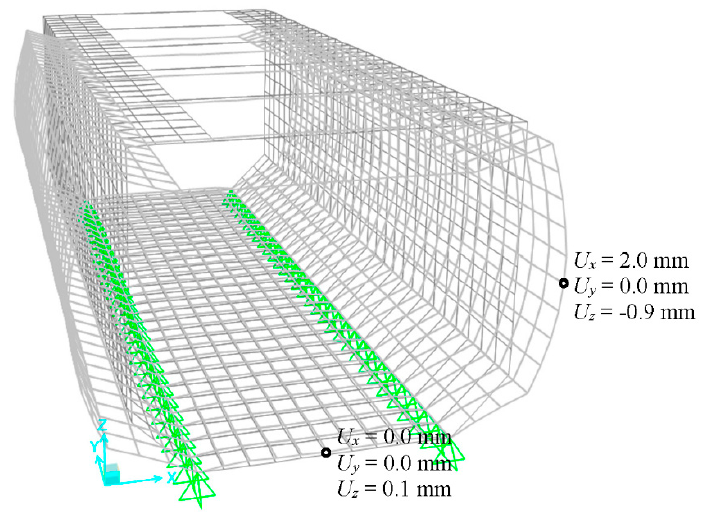
Figure 6. Deformed hydraulic cross-section when subjected to the service load combination ( C 1 ).